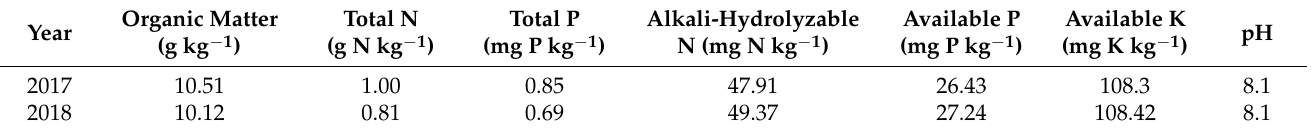
Table 5. Soil porosity and chemical characteristics of the soil of the experimental site.